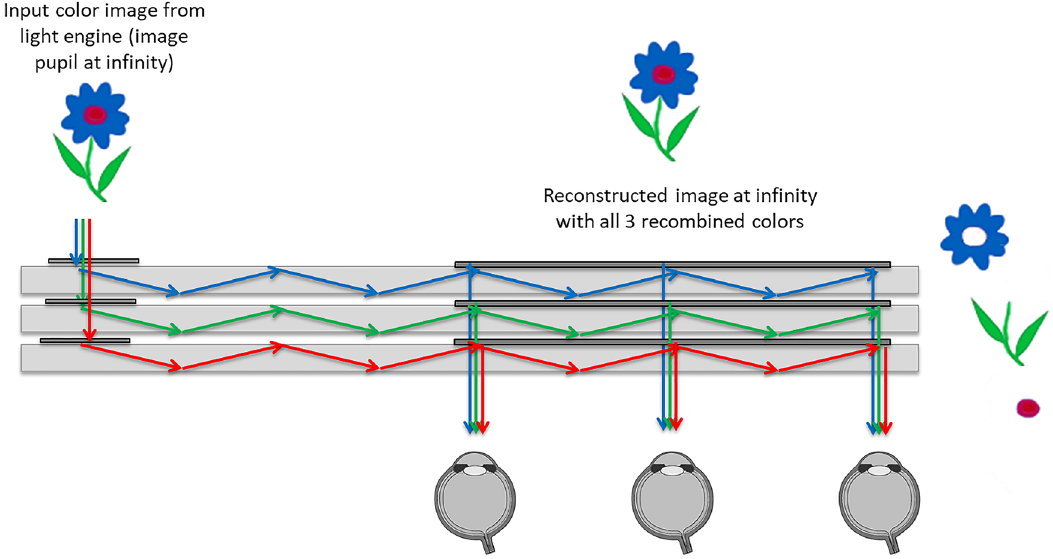
Figure 27: Stacked waveguides combiners that provide the largest FOV TIR propagation over three